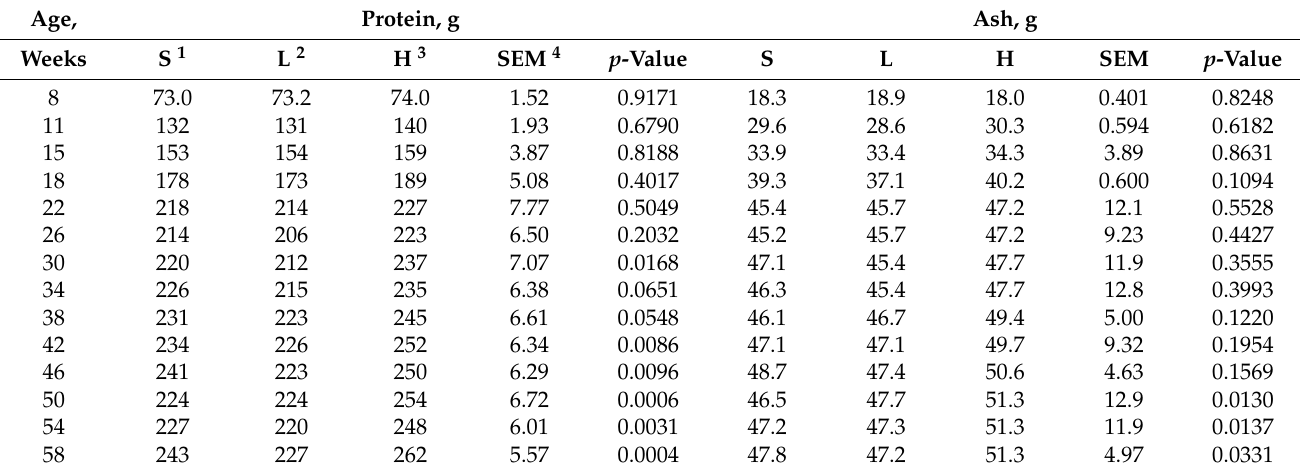
Table 7. Body protein and ash of laying hens from 8 to 102 weeks old in response to three dietary balanced protein